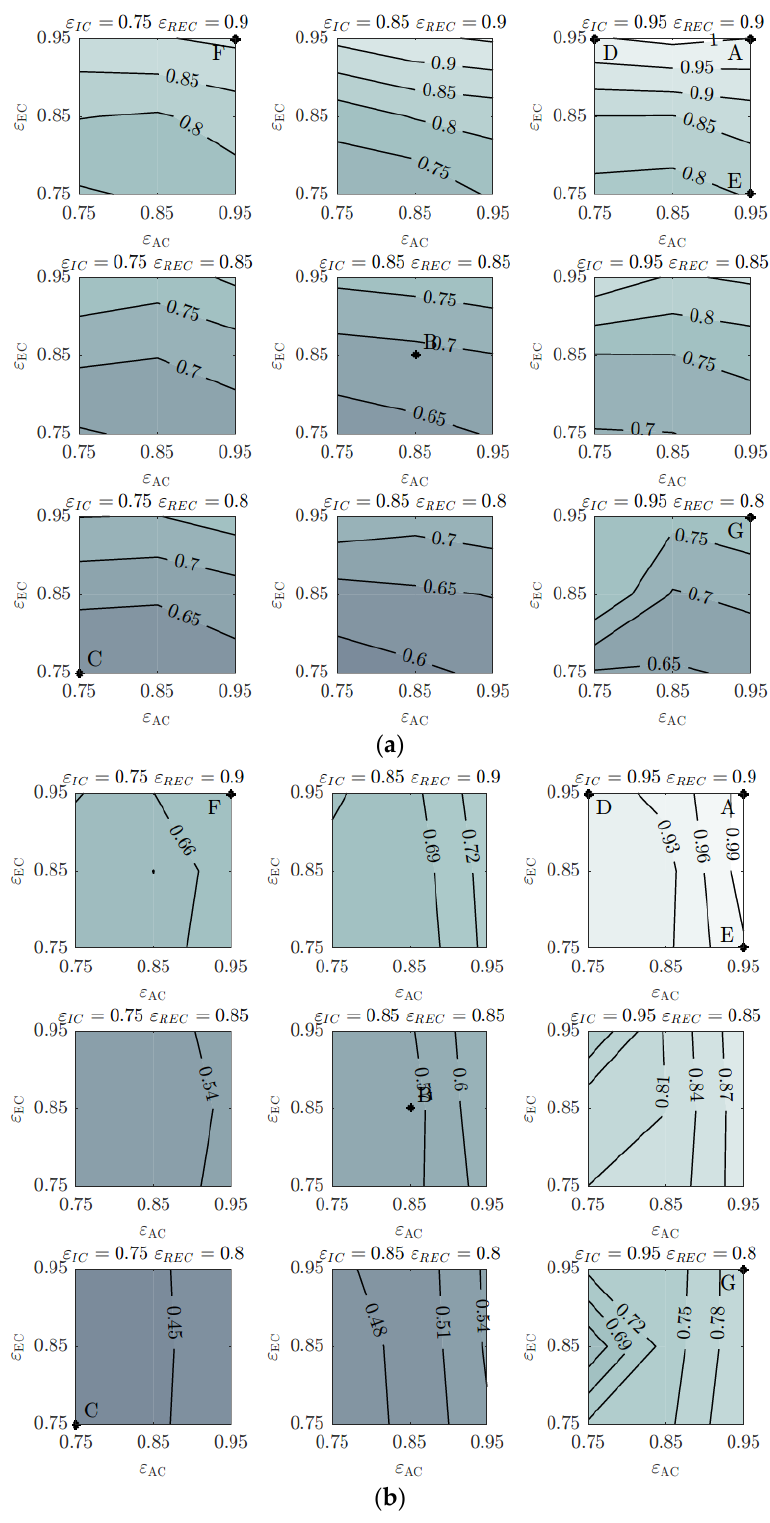
Figure 10. ( a ) heat exchanger total normalized weight and ( b ) total normalized acquisition cost index across the range of heat exchanger effectiveness for OPR = 40 & ∆ T ps = 5